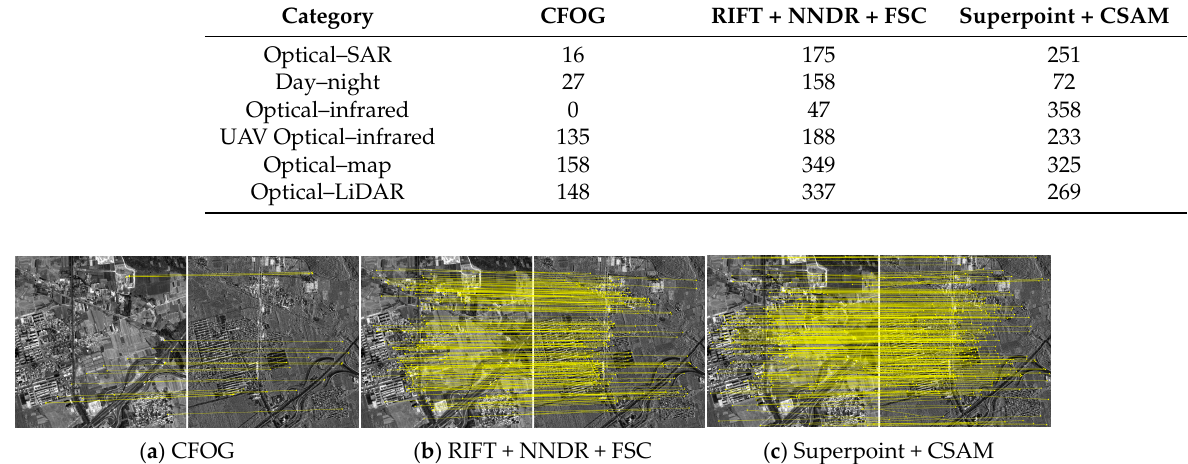
Table 3. The NCM of different methods.